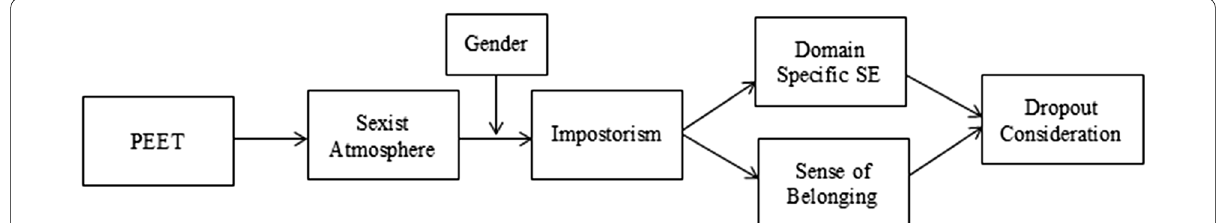
Fig. 1 Model of differential impact of perceived environmental entity theory (PEET) on consideration of dropping out STEM graduate program by